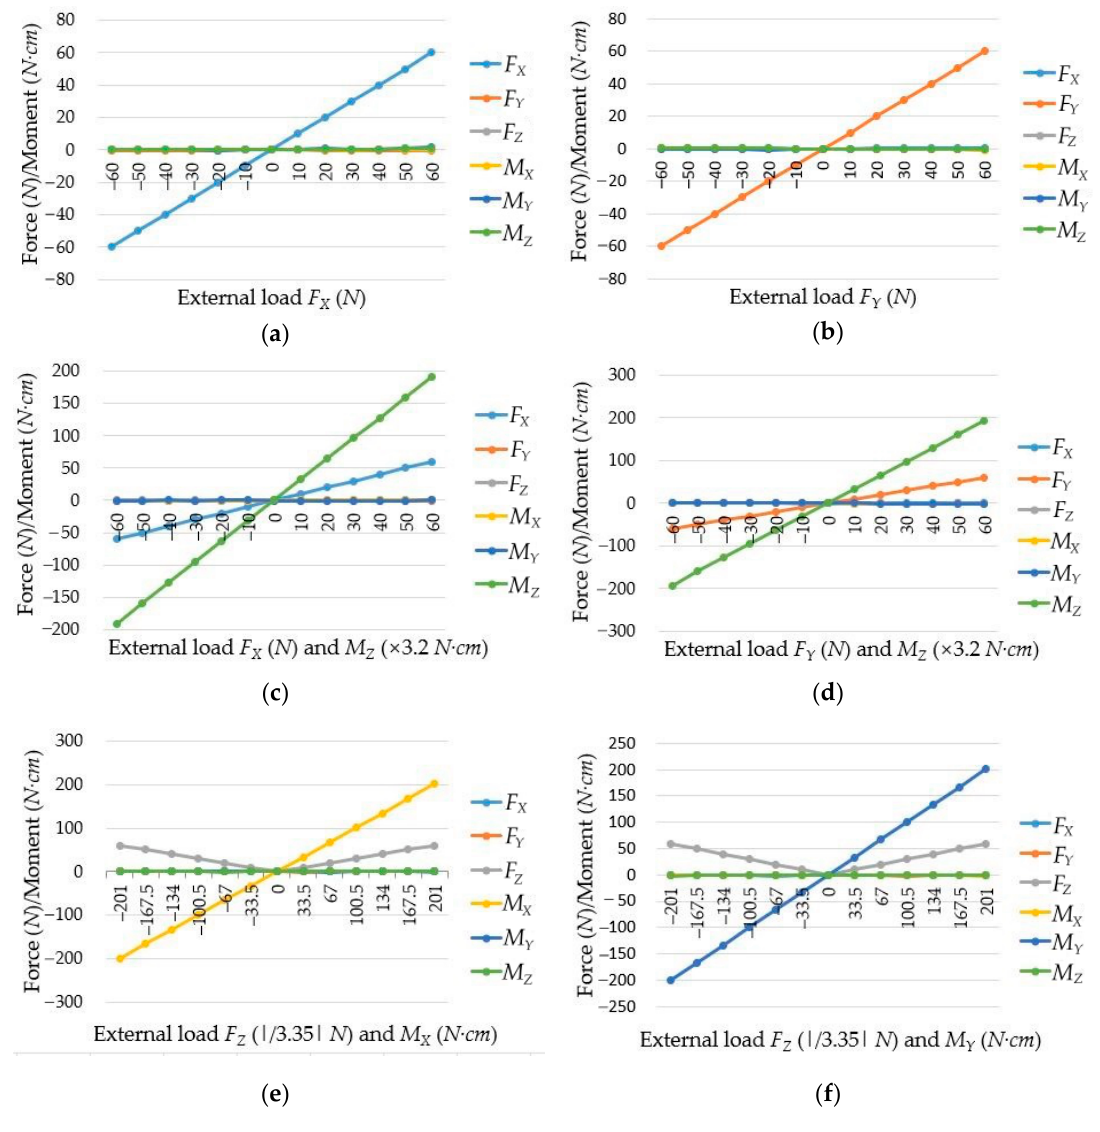
Figure 22. Force/Torque obtained by the cylindrical traction force sensor: ( a ) the force F X acts on the sensor; ( b ) the force F Y acts on the sensor; ( c ) under the force F X and torque M Z ; ( d ) under the force F Y and torque M Z ; ( e ) under the force F Z and torque M X ; ( f ) under the force F Z and torque M Y . Table 2. Interference error of the cylindrical traction force sensor.